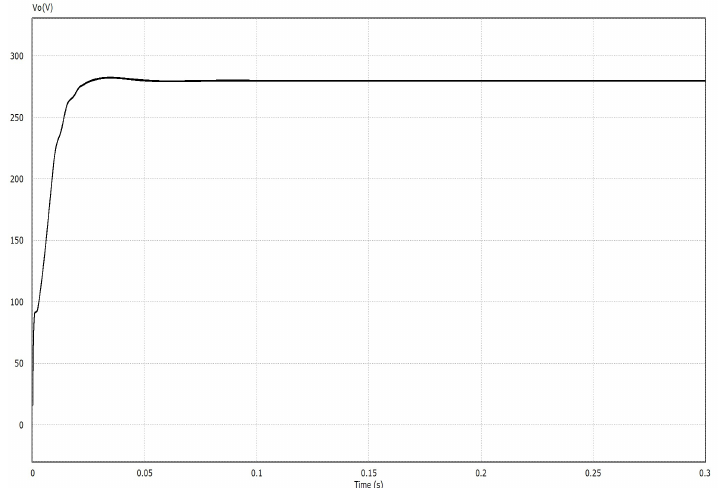
Figure 7. PSIM simulation of output voltage vs. time.